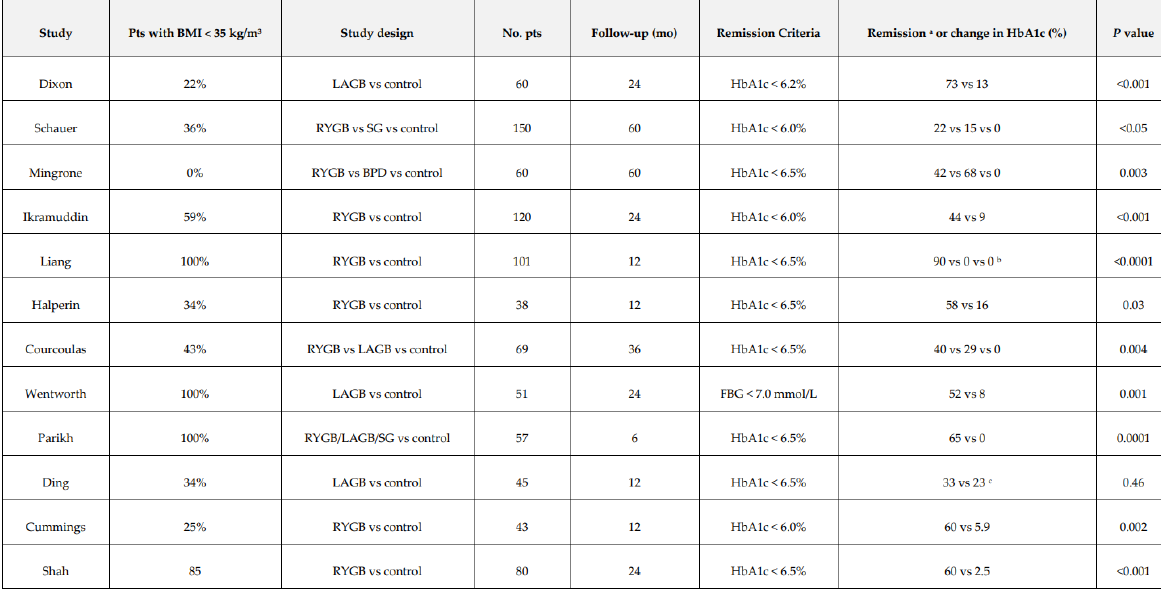
Figure 4. Metabolic surgery randomized clinical trials. Remission criteria: (a) Remission was primary or secondary end point; HbA1c value without diabetes medications, unless otherwise specific. (b) Remission was not precisely defined; HbA1c < 6.5% by extrapolation. (c) Intermittent diabetes medications. BMI = body mass index; BPD = biliopancreatic diversion; FBG = fasting blood glucose; HbA1c = glycated hemoglobin; LAGB = laparoscopic adjustable gastric band; RYGB = Roux-en-Y gastric bypass; SG = sleeve gastrectomy.